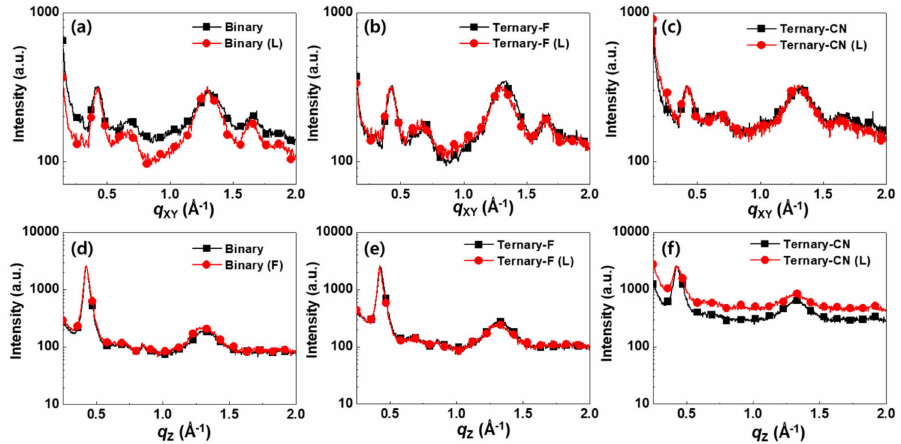
Figure 5. In-plane ( a – c ) and out-of-plane ( d – f ) Grazing incidence wide angle X-ray scattering (GIWAX)